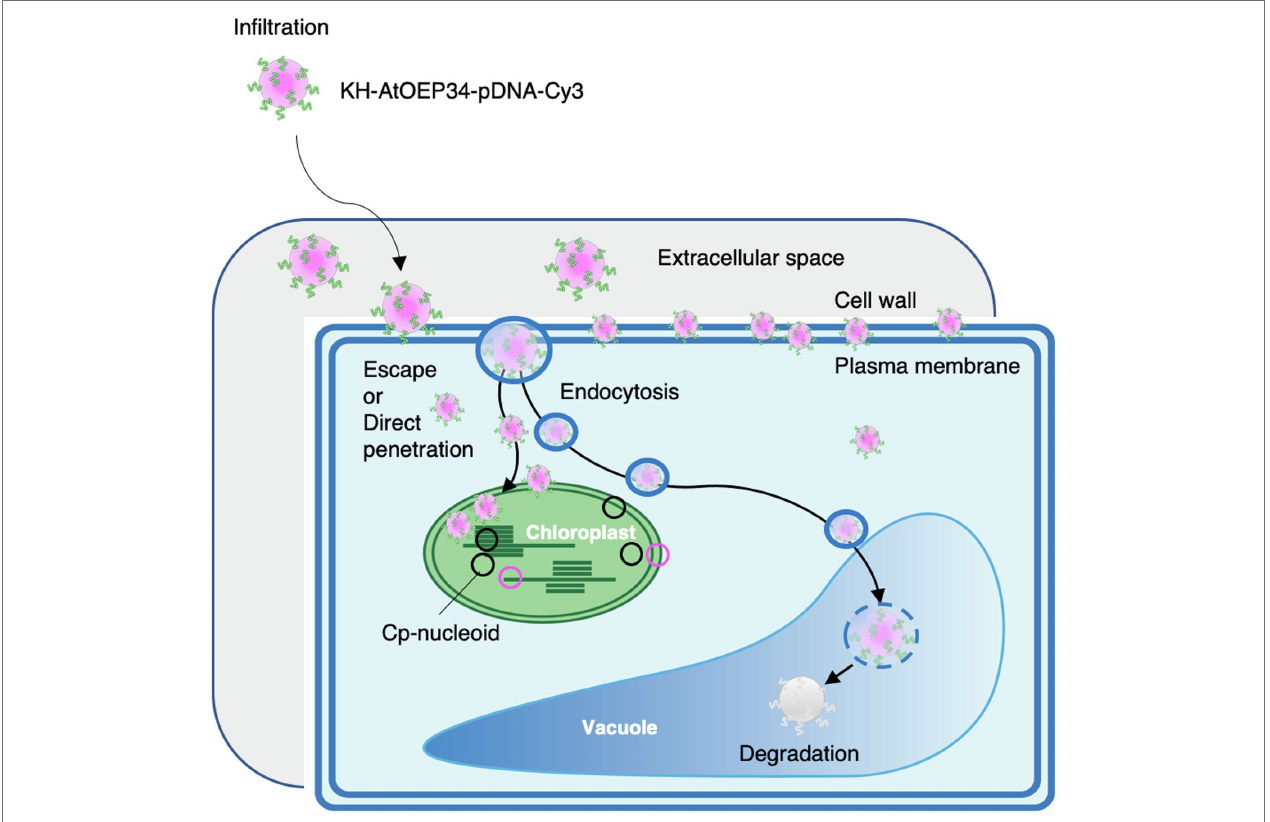
FIGURE 7 | Proposed model for the penetration of KH-AtOEP34–pDNA complexes from outside the cell to the chloroplast stroma. After infiltration of KH- AtOEP34–pDNA complexes labeled with Cy3 (cpPD-Cy3 complex) at the leaf surface, cpPD-Cy3 complexes move to the leaf extracellular space. Then, cpPD-Cy3 complexes penetrate into the cell via endocytosis or direct penetration; however, some complexes are trapped by the cell wall and/or the plasma membrane. In the cytosol, cpPD-Cy3 complexes are either targeted to the vacuole for degradation by endocytosis and autophagy, or escape from the degradation and become incorporated into the